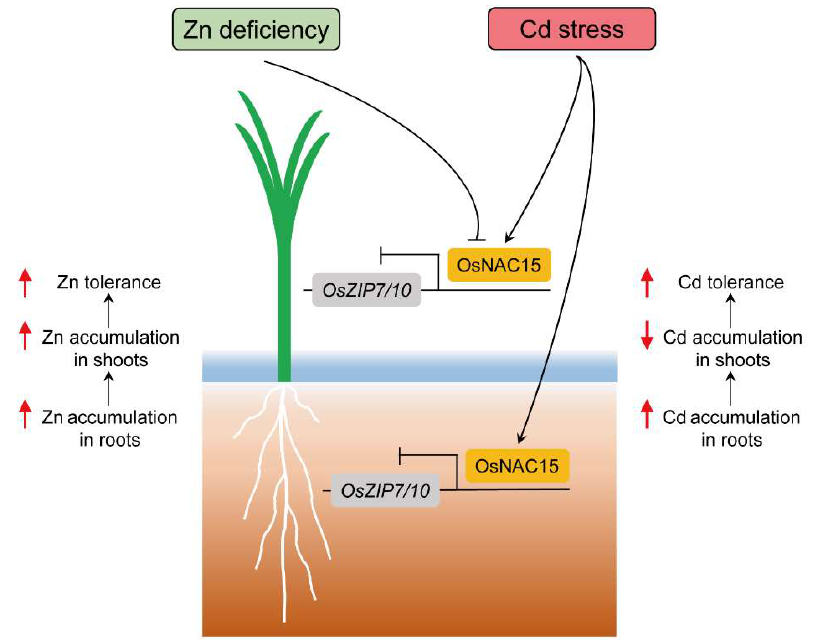
Figure 9. A working model for the OsNAC15-mediated regulation of Zn deficiency and Cd stress tolerance. OsNAC15 directly binds to the OsZIP7 and OsZIP10 promoters to inhibit their transcrip- tions, resulting in increased Zn accumulation and decreased Cd accumulation, thereby enhancing ZDT and CDT.